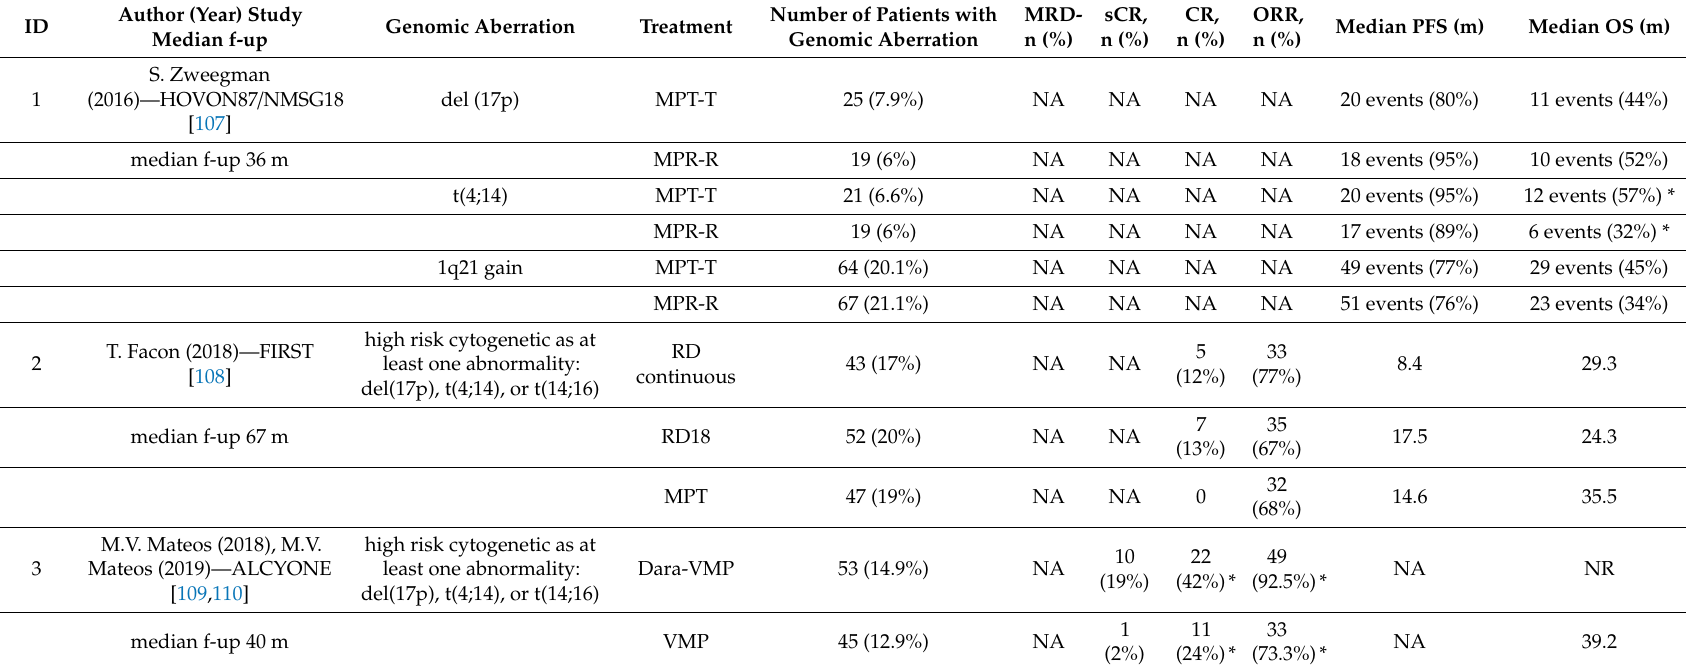
Table 4. Outcomes in transplant ineligible patients with MM that were treated at diagnosis in large phase 3 trials according to their genome aberrations. On 21 November 2020, we searched on PubMed (multiple myeloma AND phase 3 NOT relapse * NOT resist *) AND Clinical Trial[ptyp] AND “last 5 years”[PDat] and we received 39 results; these results were manually curated and all the trials including transplant ineligible patients from diagnosis and presenting evaluable randomized data on prognostic impact of genomic aberrations in MM are included in this table. M = melphalan, V = bortezomib, P = prednisone, Dara = daratumumab, R = lenalidomide, D = dexamethasone, Pembro = pembrolizumab, C = cyclophosphamide, T = talidomide, K = karfilzomib, NA = not available, sCR = stringent complete response, CR = complete remission or better, MRD- = negative measurable residual disease, NR = not reached, CI = confidence interval, f-up = follow-up, * = statistically significant between study arms in sub-cohort analysis. Descriptive sentence or number of events with median follow-up are reported whenever median PFS and / or OS are not reported for the study. Some digit may vary from the original report due to